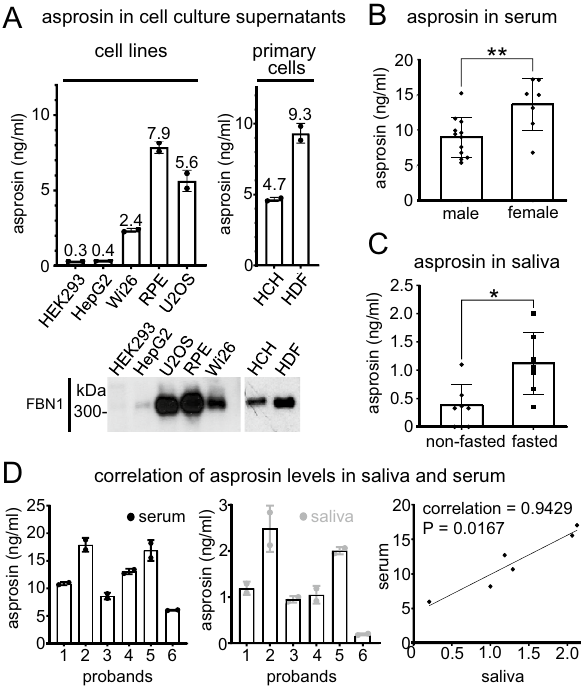
Figure 4. Asprosin levels in serum and saliva depend on biological sex, fasting, and show a strong correlation. ( A ) (top left) Endogenous asprosin levels in various human cell lines supernatants and (top right) primary human cells (human dermal fibroblasts and human chondrocytes) were measured using asprosin sandwich ELISA (n = 2 per each group). (bottom) western blot showing the corresponding fibrillin-1 expression in cell lines supernatants. ( B ) Comparative analysis of asprosin levels in blood serum (25 µl serum fourfold diluted in 75 µl PBS) of male and female groups (n = 19, m/f = 12/7, age = 30.4 ± 6.4 years, weight (W) = 72.9 ± 11.3 kg, height (H) = 1.75 ± 0.08 m, BMI = 23.7 ± 2.9 kg/m 2 ) using sandwich ELISA and analyzed by unpaired two-tailed t-test, ** P = 0.0072. ( C ) Assessment of asprosin levels in saliva (100 µl saliva) in fasting (overnight fasting, 8–9 h) and non-fasting (3 h after lunch) conditions by sandwich ELISA (n = 7, m/f = 3/4, age = 32.3 ± 8.71 years, weight = 70.5 ± 13.8 kg, height = 1.74 ± 0.09 m, BMI = 23.3 ± 3.04 kg/m 2 ) and analyzed by Wilcoxon matched-pairs signed-rank test, * P = 0.0156). ( D ) (left and middle) Quantification of asprosin levels in human serum and saliva respectively in fasted condition (overnight fasting) by sandwich ELISA (n = 6, m/f = 3/3, age = 32.7 ± 9.09 years, weight = 64.5 ± 8.77 kg, height = 1.71 ± 0.07 m, BMI = 22.1 ± 2.44 kg/m 2 ). (right) Correlation of asprosin levels in human serum and saliva using Spearman correlation = 0.94, * P = 0.02, (n = 2 per each group). Data were analyzed using Graphpad Prism version 8.0.2.